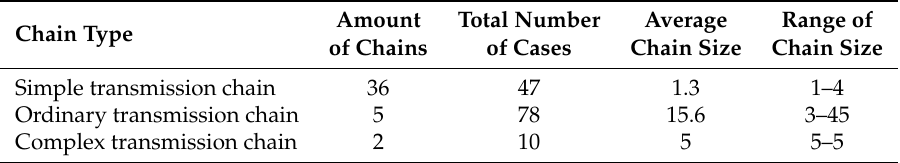
Table 1. Three types of COVID-19 transmission chains in